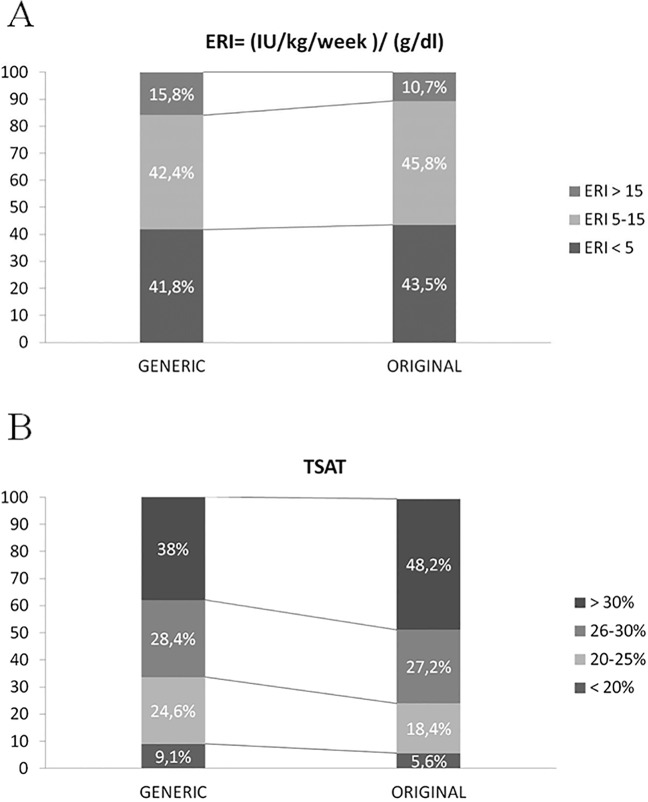
Distribution of the population depending on ERI (4A) or TSAT levels (4B).